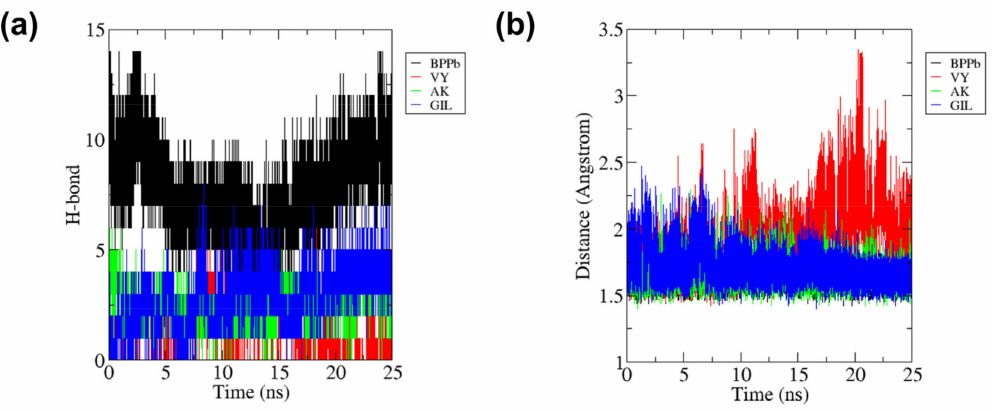
Figure 7. ( a ) Total number of hydrogen bonds interactions between ACE and each peptide and ( b ) intermolecular distance of ACE with peptides during 25 ns of the molecular dynamics simulation pe- riod.